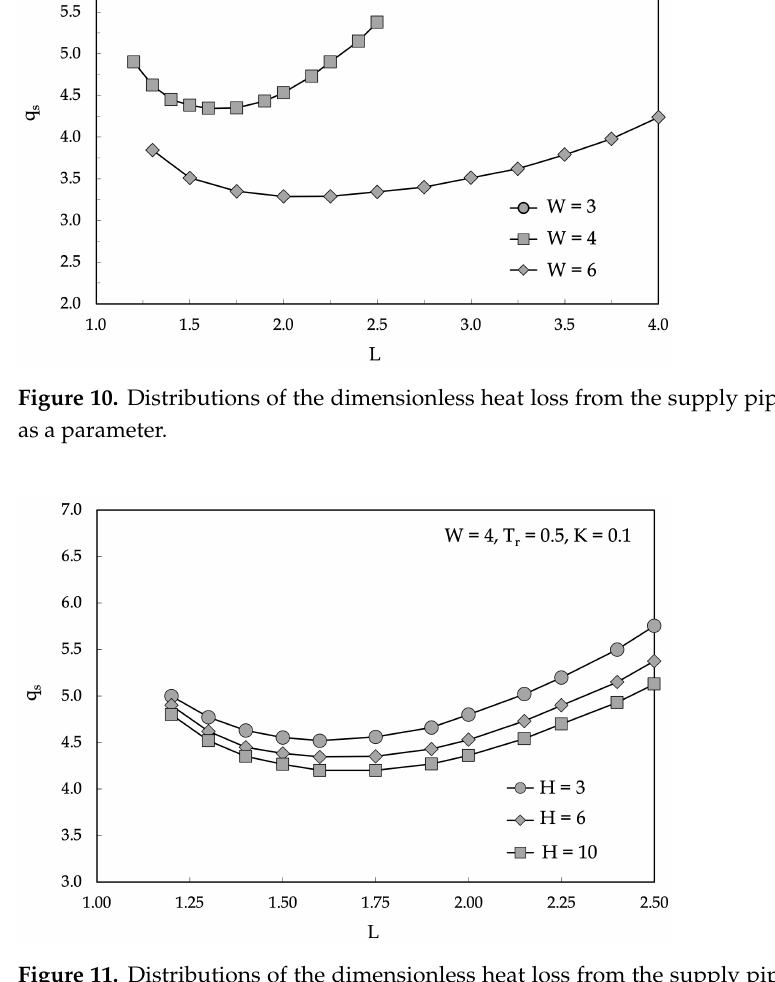
Figure 11. Distributions of the dimensionless heat loss from the supply pipe q s versus L using H as a